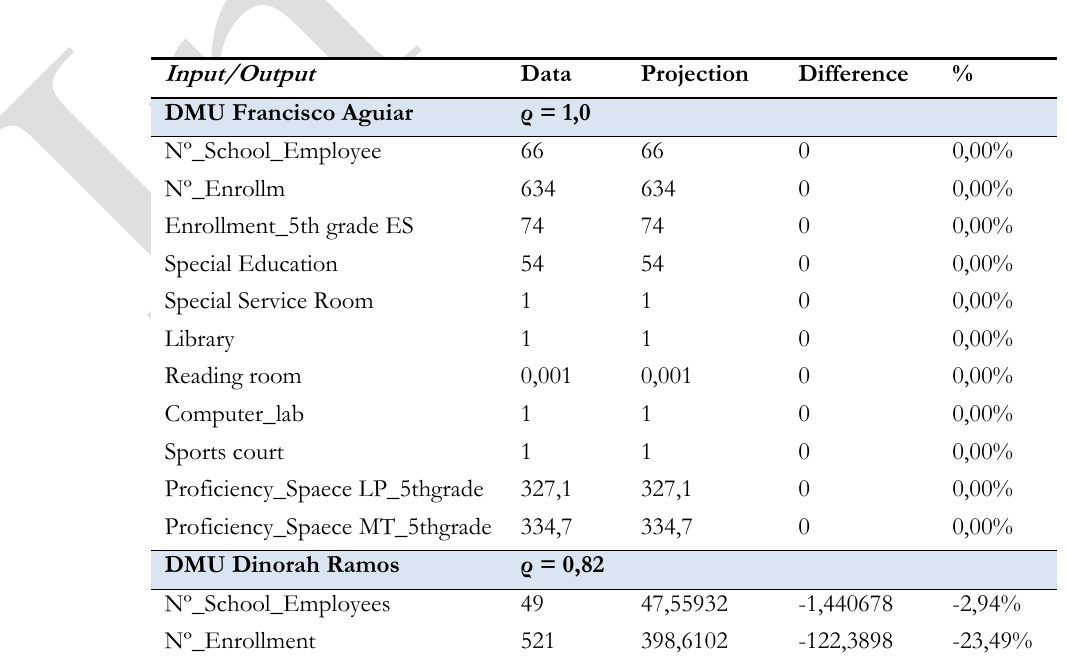
Table 4 - Projection of the Factors of two DMUs in Sobral.